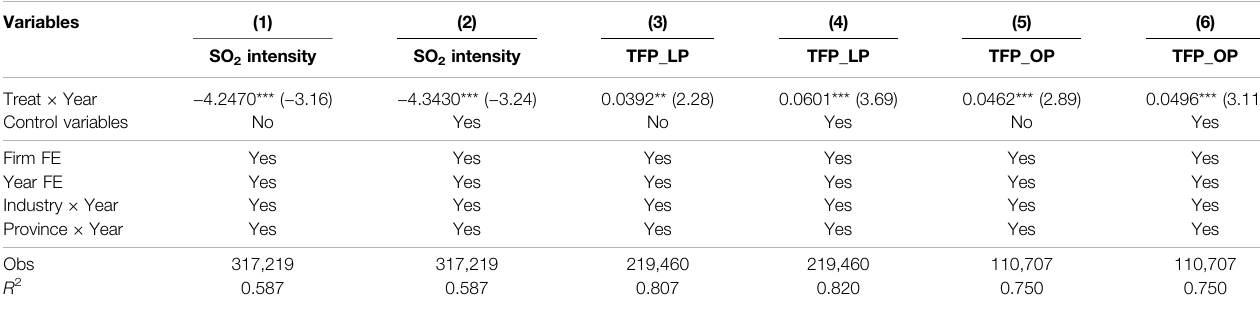
TABLE 7 | Results of replacing dependent variables.